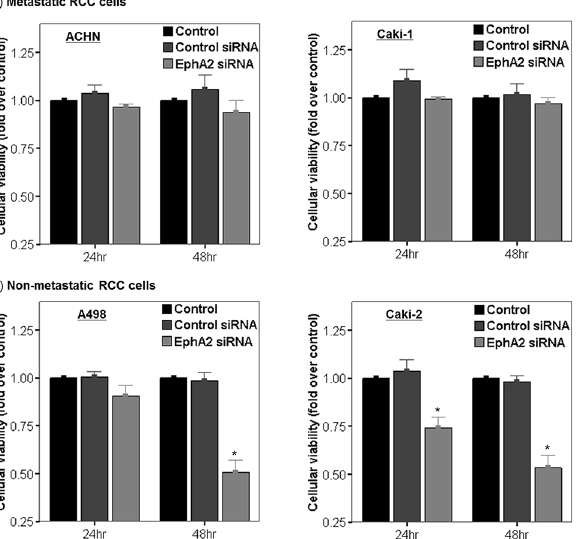
Fig 3. Effect of EphA2 siRNA on cellular viability in (A) metastatic RCC cell lines (ACHN and Caki-1) and (B) non-metastatic RCC cell lines (A498 and Caki-2). Cellular viability was compared among untreated cells (control), control siRNA treated cells and EphA2 siRNA treated cells at 24 and 48 hours following treatment in each cell line. The results were presented as fold changes over controls. * p < 0.05 vs. control and control siRNA treated groups. siRNA = small interfering RNA, RCC = renal cell